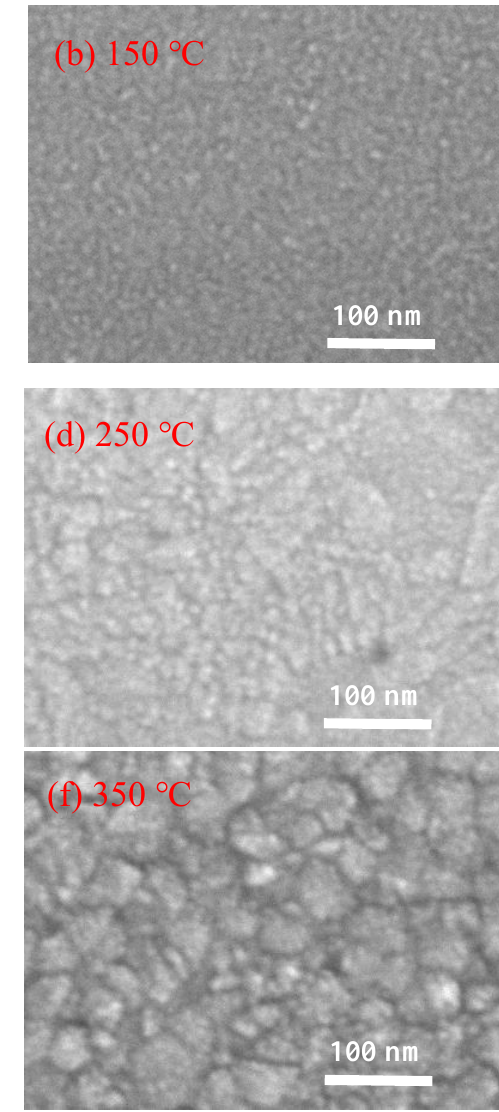
Figure 4 . ( a ) The grazing incident X-ray diffraction (XRD) patterns of In 2 O 3 films deposited at different substrate temper- atures; ( b ) variation of full width at half maximum (FWHM) for the (2 2 2) peak and the size of the (2 2 2)-orientated crystallites with substrate temperature. N.A. is the abbreviation for not available.